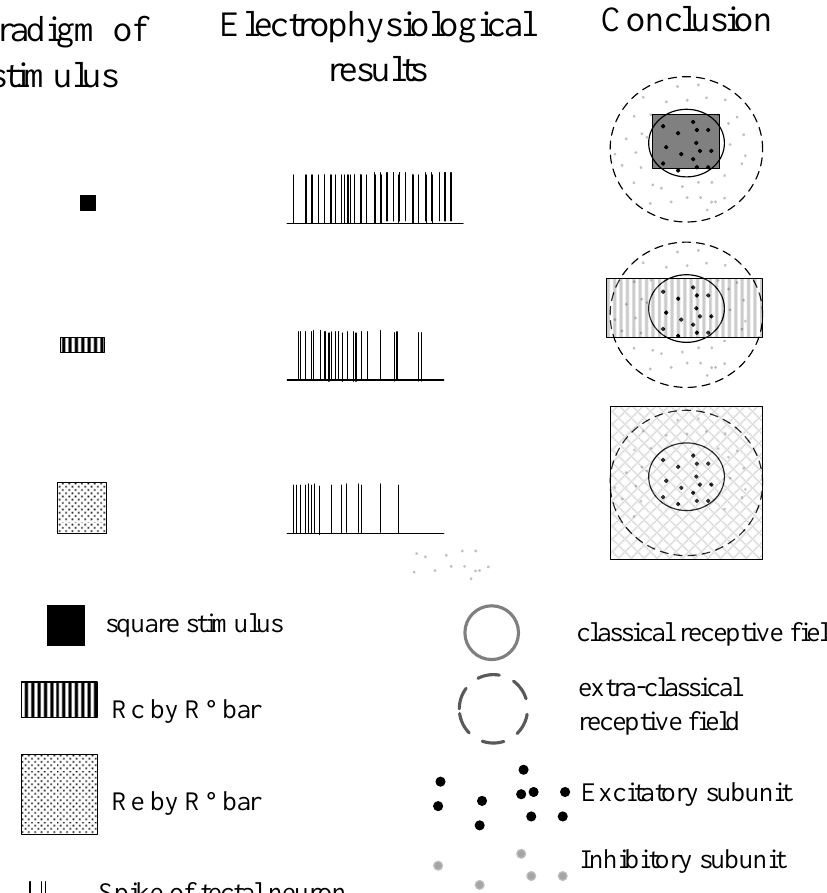
Figure 6. Illustration of data and conclusions. Tetcal response (middle subfigure to different sizes of flashed squares and bars (left subfigure) suggest that inhibitions performed on tectal neurons appear to be full surrounding rather than locally lateral (right subfigure). The solid line circle in each subfigure indicates the classical receptive field area and the dotted circle indicates the extra-classical receptive field area.